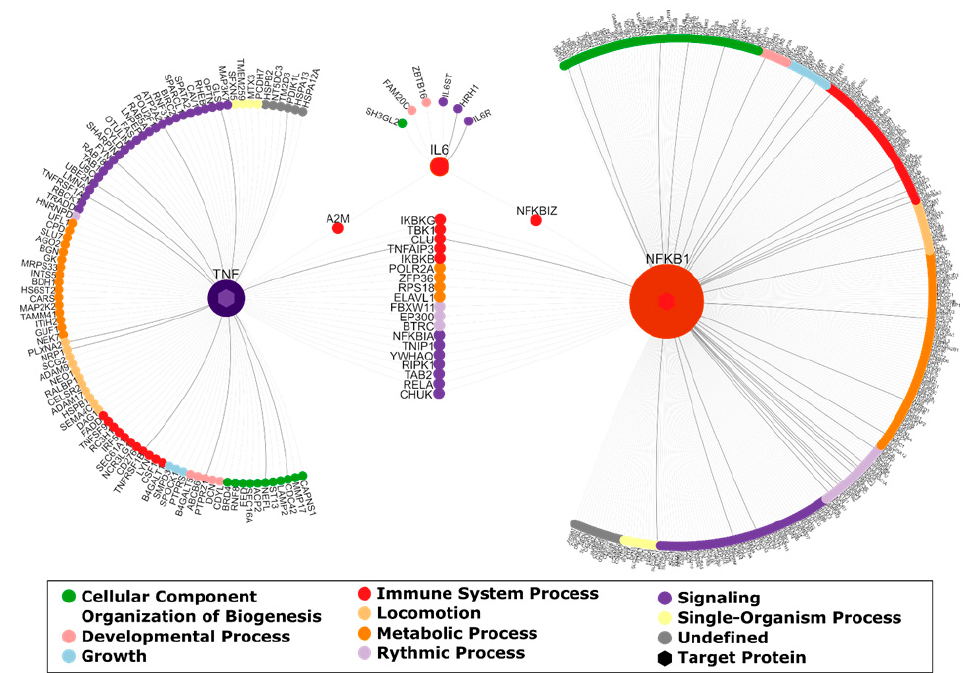
Figure 4. Brain-PPI (protein–protein interaction) network for interleukin-6 (IL-6), tumor necrosis factor (TNF) and nuclear factor kappa B subunit 1 (NFKB1). Interactions between proteins are visualized by edges. Edges that are associated with diseases of mental health are highlighted in black. Moreover, each protein is colored according to their top-level biological process. The degree of the target proteins is emphasized by node size. Nutrients 2020 , 12 , x FOR PEER REVIEW